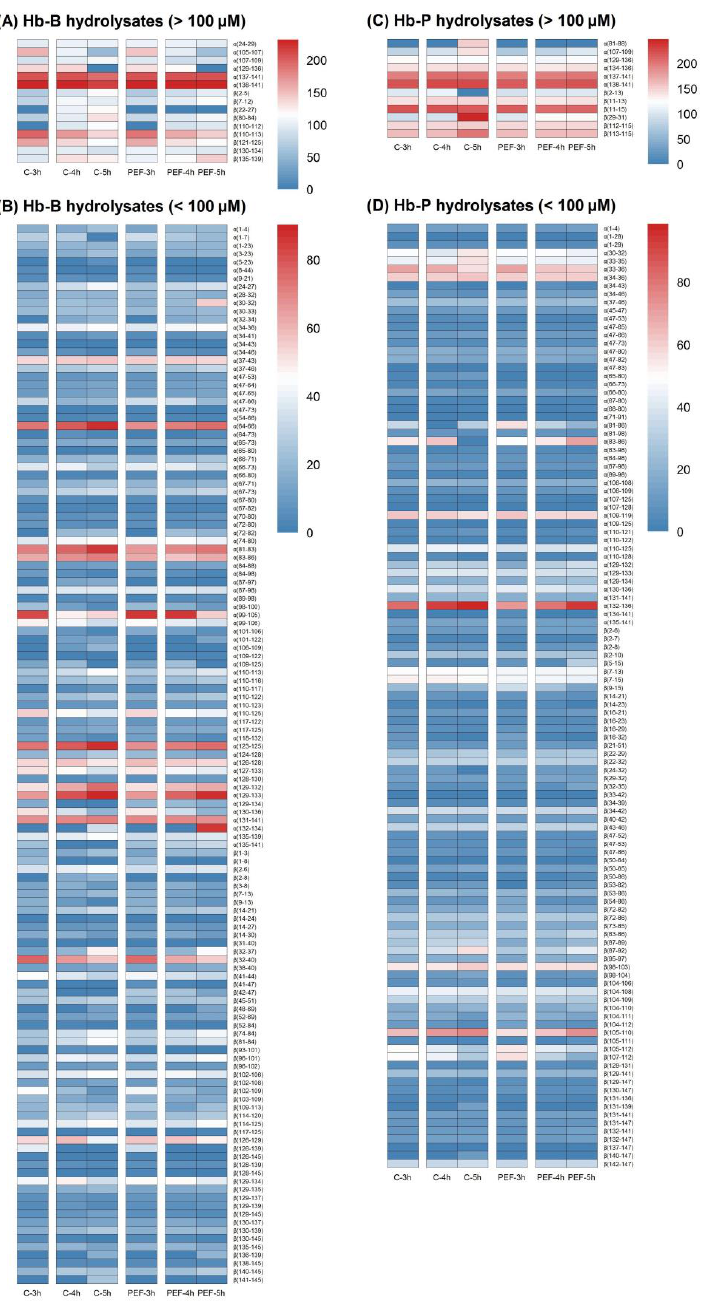
Figure 4. Heat map based on peptide concentration (µM) of identified peptides in untreated (C, control) and PEF-treated Hb-B ( A , B ) and Hb-P ( C , D ) hydrolysates. Identified compounds are labeled by their location in the sequences of alpha chain or beta chain. Treatments and peptides are visualized in each column and row, respectively. Values in the diagram were calculated from the average of 3 replicate samples.